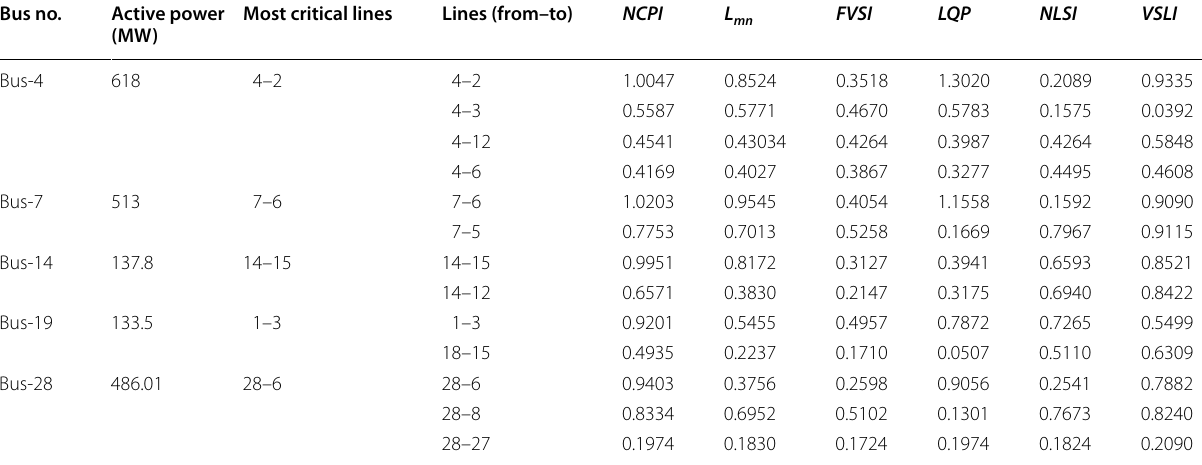
Table 2 Heavy active power at some load buses of the IEEE 30-bus test system Bus